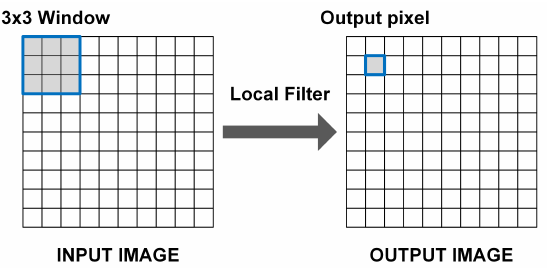
Figure 1. Local filtering process. Grey-shaded pixels on the input image represent the square window that feeds the local filter. The resulting filtered pixel replaces the center pixel of the window. The window is moved along the image to generate all the output pixel